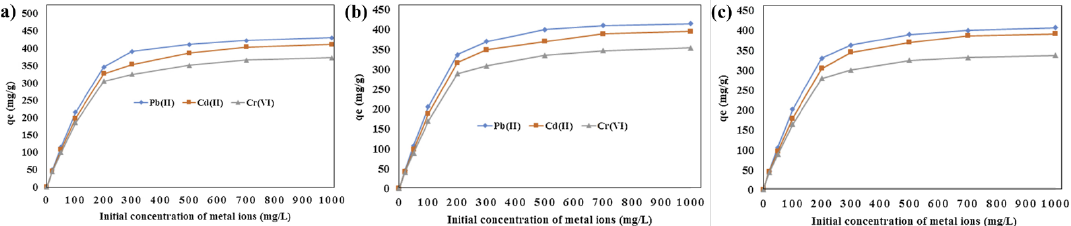
Figure 7. Effect of initial concentration of ( a ) Pb (II), ( b ) Cd (II), and ( c ) Cr (VI) ions on the adsorption of metal ions using PAN/chitosan/UiO‑66‑NH 2 nanofibrous adsorbent. Reprinted with permission from ref. [64]. Copyright 2019